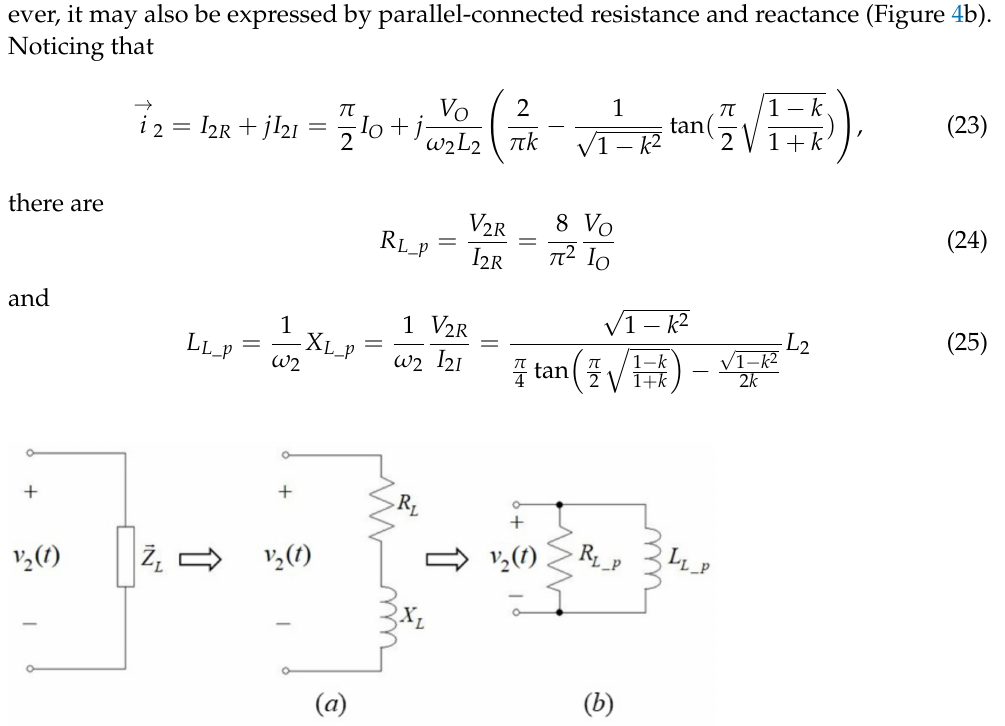
Figure 4. Equivalent load impedance circuit: ( a ) series form, ( b ) parallel